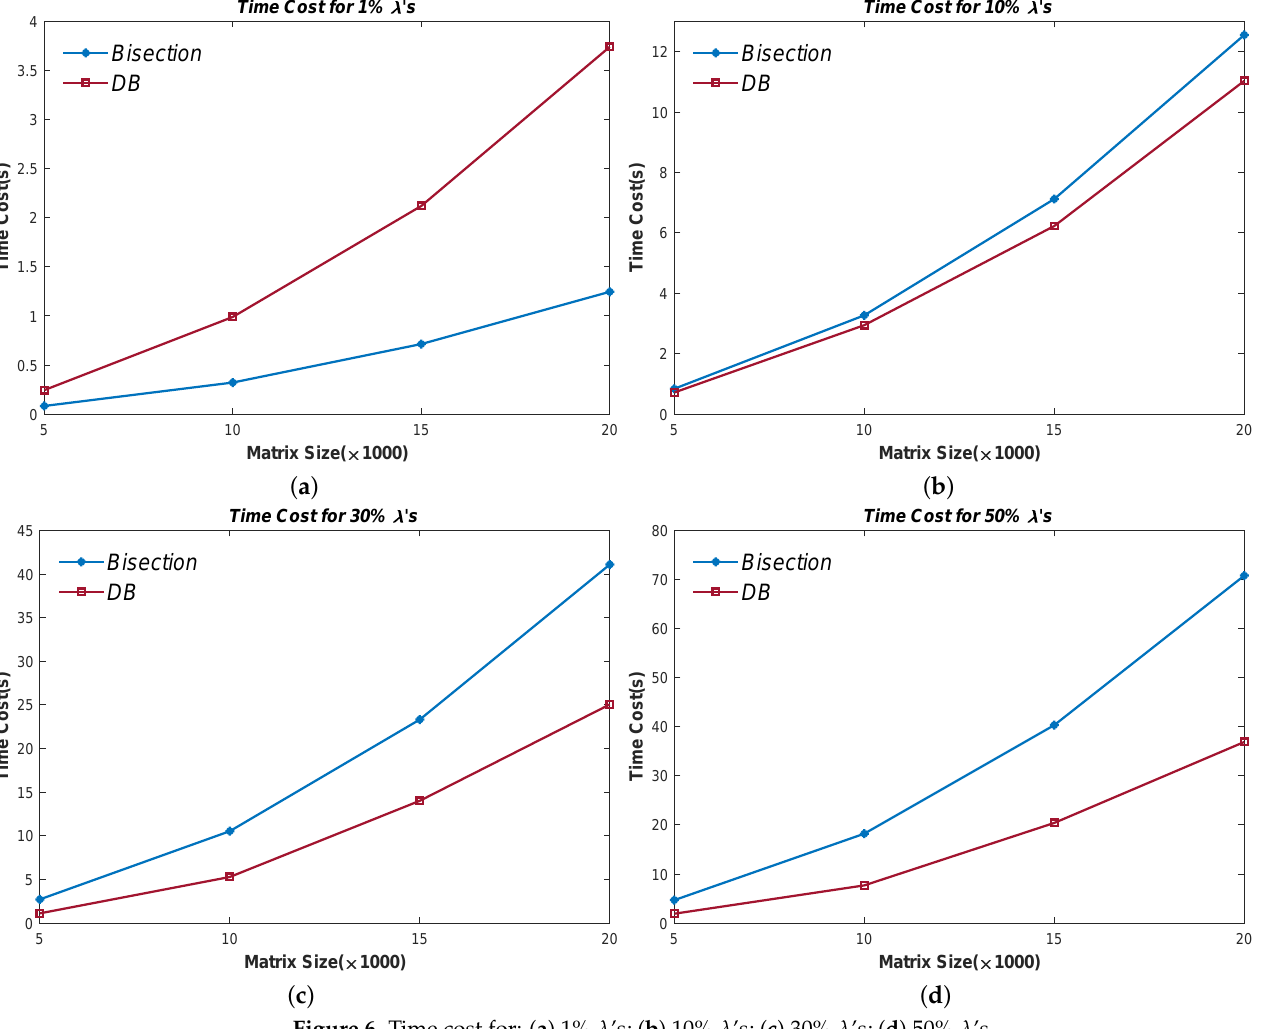
Figure 6. Time cost for: ( a ) 1% λ ’s; ( b ) 10% λ ’s; ( c ) 30% λ ’s; ( d ) 50% λ